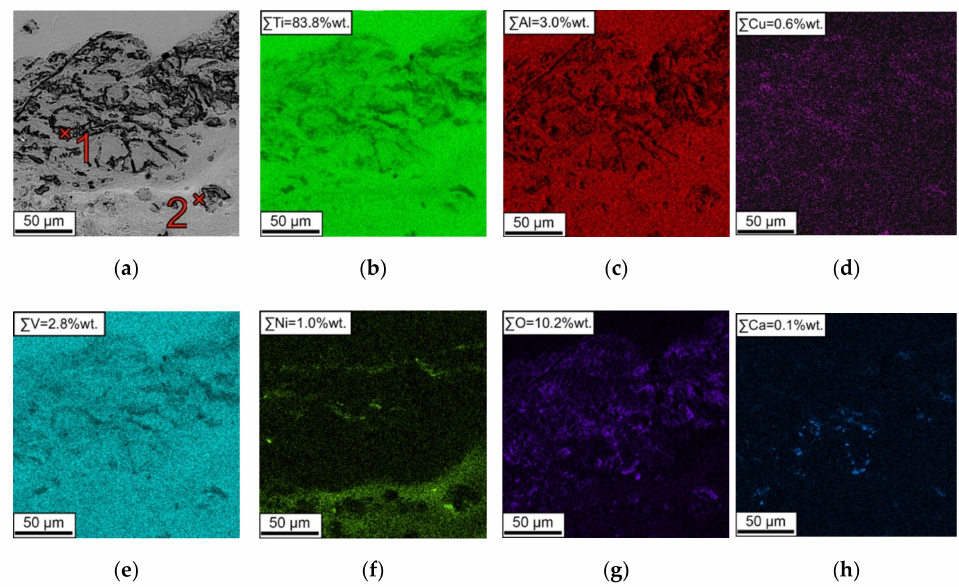
Figure 8. EDX-mapping of the stir zone area with inclusions in sample 2: ( a ) BSE-image; ( b ) titanium, ( c ) aluminum, ( d ) copper, ( e ) vanadium, ( f ) nickel, ( g ) oxygen and ( h ) calcium